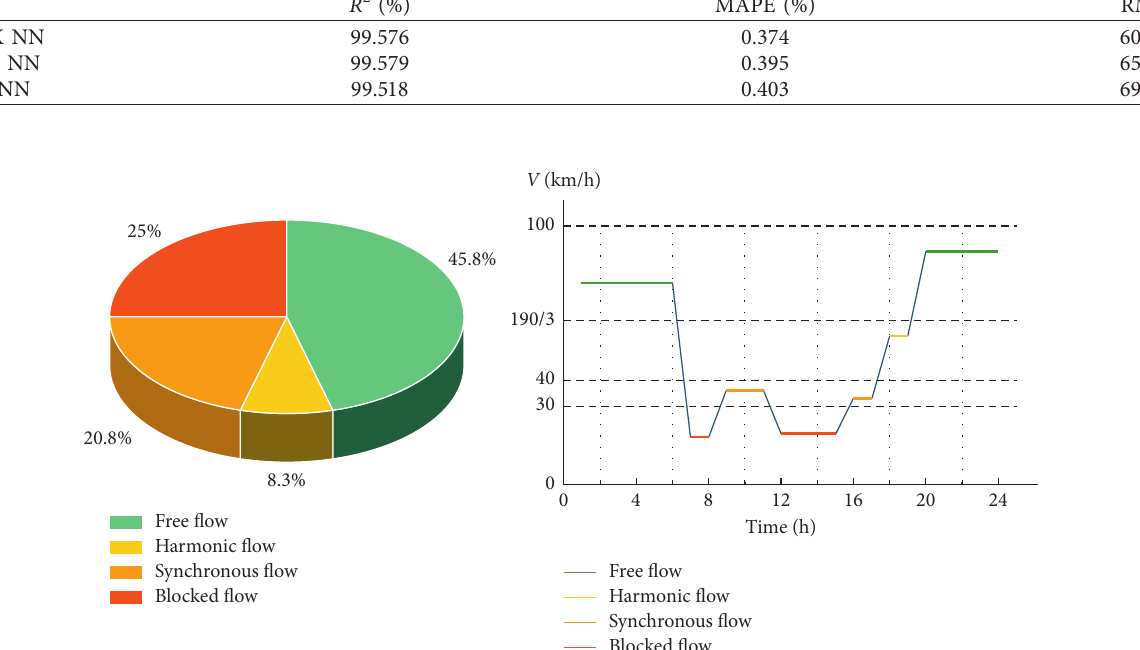
Figure 13: Predicted traffic distribution by the time of day.